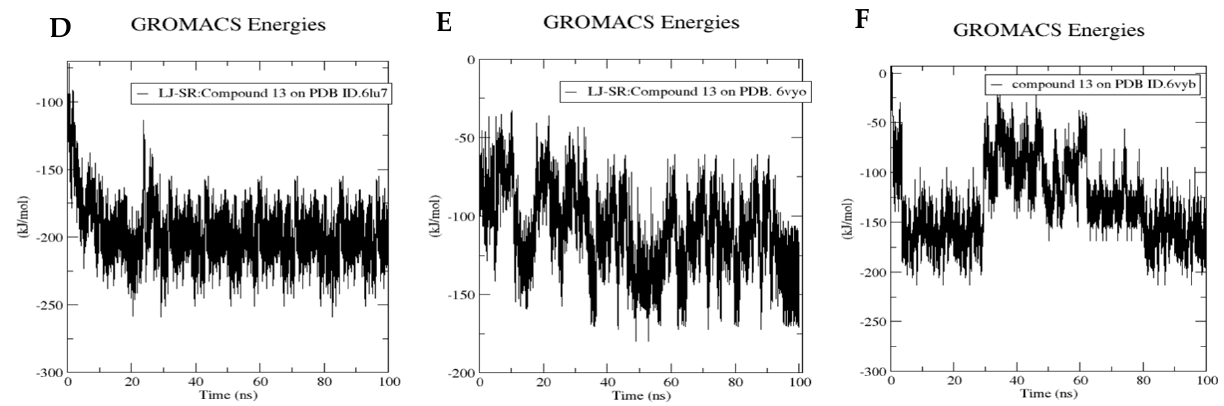
Figure 19 . Molecular dynamics of compound 5 bound to PDB ID. 6lu7 (A), 6VYO (B) and 6W4H (C) and compound 13 Figure 19. Molecular dynamics of compound 5 bound to PDB ID. 6lu7 ( A ), 6VYO ( B ) and 6W4H ( C ) and compound 13 bound to PDB ID. 6lu7 (D), 6VYB (E) and 6VYO (F). Binding energy using LJ-SR. bound to PDB ID. 6lu7 ( D ), 6VYB ( E ) and 6VYO ( F ). Binding energy using